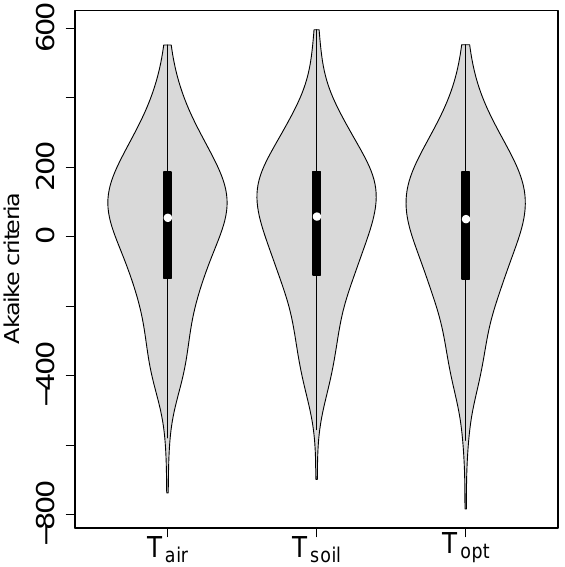
Fig. 4. Median of the Akaike information criterion for 12-days win- dows with significant correlation with nighttime NEE for all in- cluded annual datasets. The point indicates the median, the thick black line is the interquartile range. The median values are (from left to right) 56.6, 60.1, 52.8.